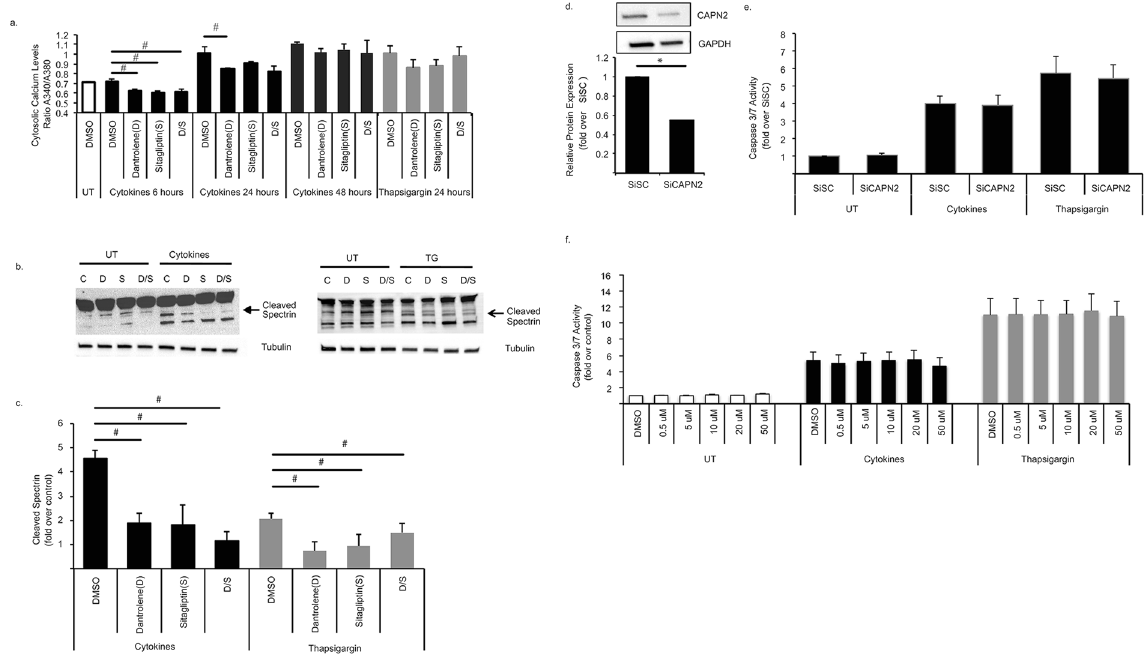
Figure 4. Dantrolene and Sitagliptin Significantly Decrease Calpain Activation in INS-1E Cells. ( a ) INS-1E cells were pre-treated with 100 nM dantrolene or 200 nM sitagliptin for 24 hours then stressed for 6–48 hours with cytokine cocktail (IL-1 β and IFN- γ 50 ng/mL) or 10 nM thapsigargin. ( a ) cytosolic free calcium activity was determined in INS-1E cells via Fura-2 assay and presented as A340/A380. ( b ) Calpain activation was measured via immunoblot for spectrin cleavage products and ( c ) quantitative densitometry was performed via ImageJ software (NIH). Full-length blot can be seen on-line (Supplementary Figure 1). ( d ) INS-1E cells were transfected with SiRNA against a scrambled construct (SiSC) or calpain 2 (SiCAPN2) and immunoblot was performed for calpain-2 expression. ( e ) SiSC and SiCAPN2 transfected INS-1E cells were then exposed to cytokines (IL-1 β and IFN- γ 50 ng/mL) or 10 nM thapsigargin for 24 hours and cell death was measured via caspase 3/7 activity. ( f ) INS-1E cellspre-treated for 24 hours with varying doses of calpain inhibitor III. Cells werethen stressed with cytokines (IL-1 β and IFN- γ 50 ng/mL) or 10 nM thapsigargin for 24 hours and cell death was monitored via caspase 3/7 activity. Data are expressed asmean ± SEM from at least three independent experiments. # p < 0.05 compared tocytokine or TG treated cells unpaired t-test. Full-length blot can be seen on- line (Supplementary Figure